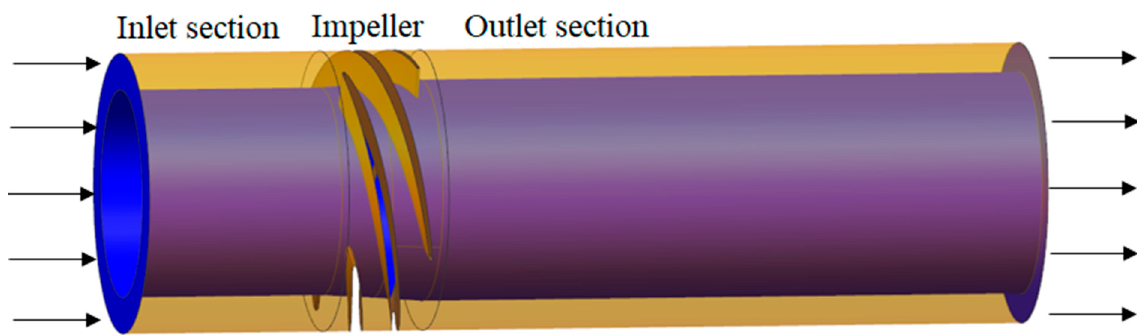
Table 1. Main design parameters of the multiphase pump.